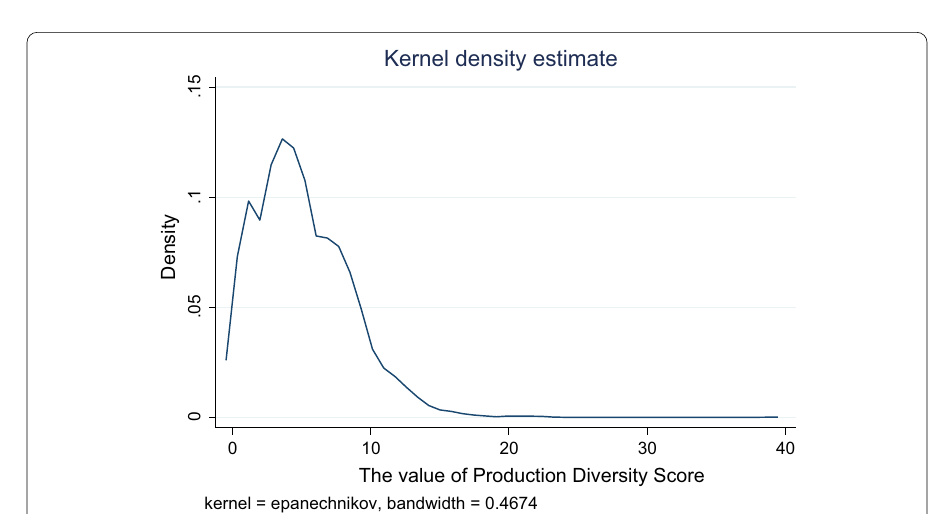
Table 4 Results of pooled, fixed-effect and random effects Poisson regression model